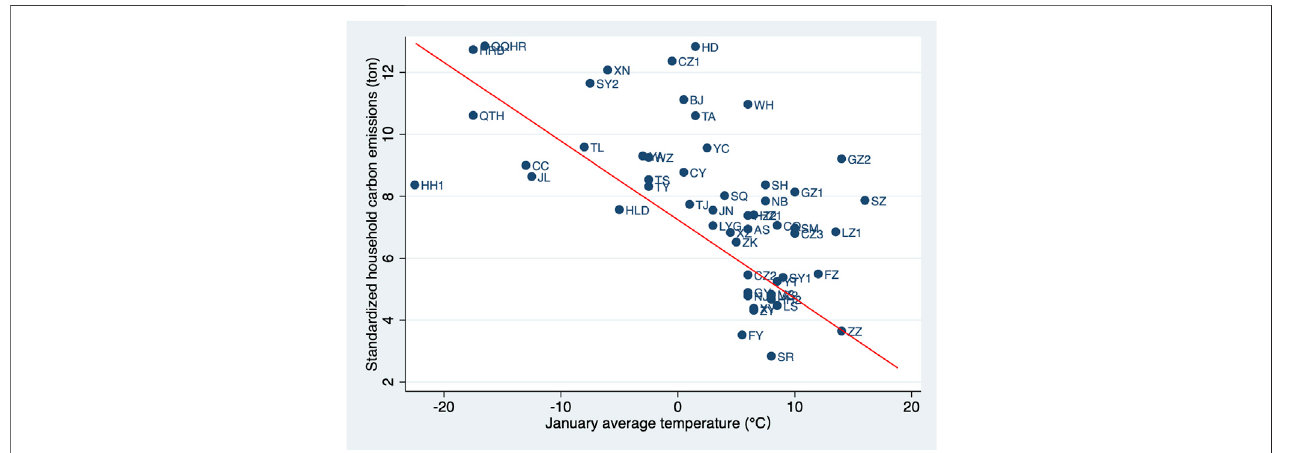
FIGURE 1 | The cross-city relationship between winter temperature and household carbon emissions. Note: The corresponding abbreviations and full names of each cityareasfollows:AS,Anshun;BJ,Beijing; CC,Changchun;CZ1, Changzhi;CZ2, ChangZhou;CY, Chaoyang; CZ3, Chenzhou; CQ,Chongqing;FY,Fuyang; FZ, Fuzhou;GY,Guiyang;GZ1,Ganzhou;GZ2,Guangzhou;HD,Handan;HZ1,Hangzhou;HRB,Harbin;HH1,Heihe;HH2,Huaihua;HLD,Huludao;HZ2,Huzhou;JL,Jilin; JN, Jining; LS, Leshan; LYG, Lianyungang; LZ1, Liuzhou; LZ2, Luzhou; MS, Meishan; NJ, Nanjing; NB, Ningbo; QQHR, Qiqihar; QTH, Qitaihe; SM, Sanming; SH, Shanghai; SQ, Shangqiu; SY1, Shaoyang; SY2, Shenyang; SY3, Shangrao; SZ, ShenZhen; TA, Taian; TY, Taiyuan; TS, Tangshan; TJ, TianJin; TL, Tieling; WH, Wuhan; WZ, Wuzhong; XY, Xiangyang; XN, Xining; XZ, Xuzhou; YA, Yan ’ an; YT, Yingtan; YC, Yuncheng; ZZ, Zhangzhou; ZK, Zhoukou; ZY,